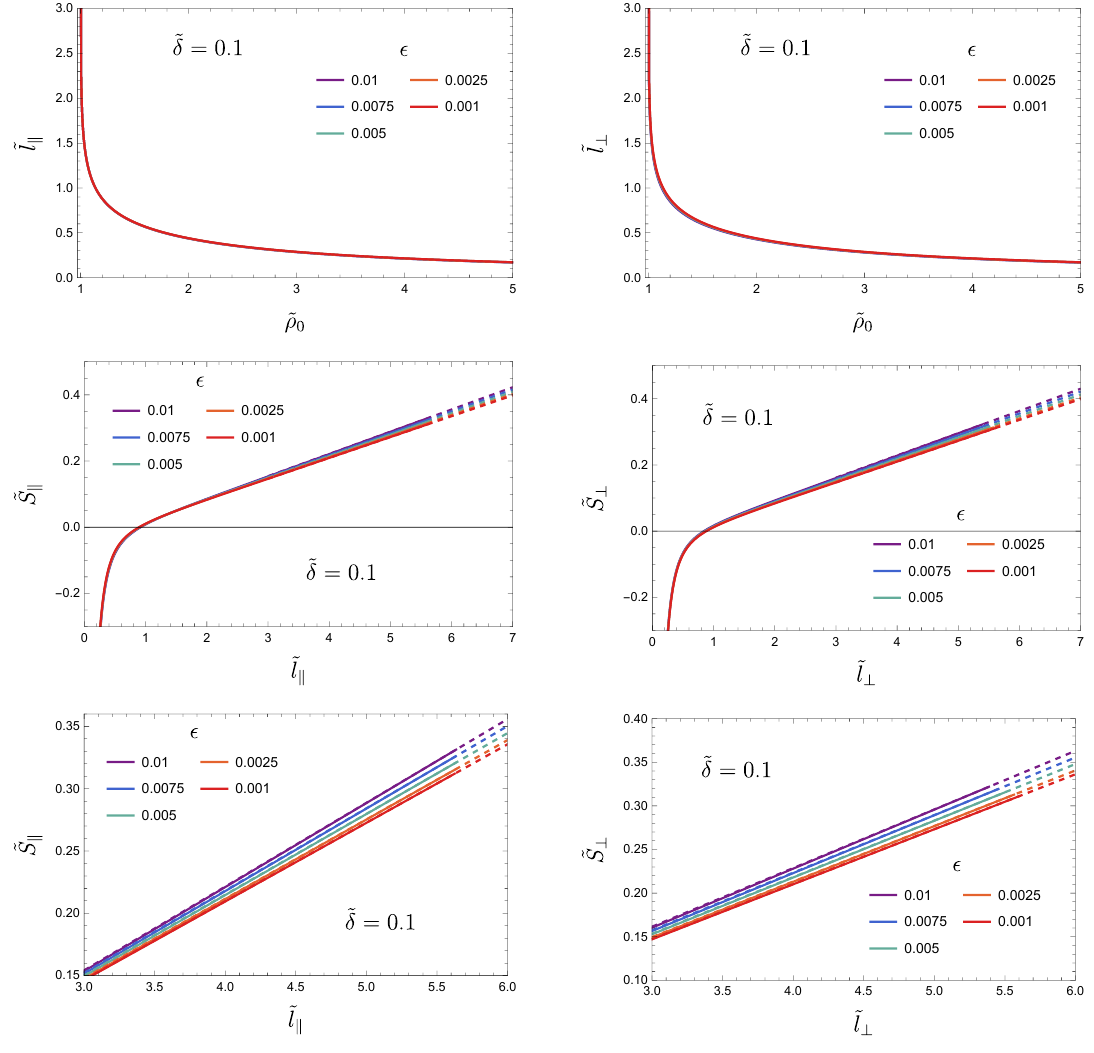
Figure 4 . First row: rescaled parallel (left) and transverse (right) width ˜ l = π T l versus the rescaled turning point ˜ ρ 0 = ρ 0 . Second and third rows: rescaled parallel (left) and transverse (right) ρ h entanglement entropy ˜ S = Vol( M 5 ) S reg versus the rescaled width. The slope of the dashed 8 π 4 L 2 L 3 N 2 c T 2 lines are fixed by the thermal entropy density according to (6.42) and (6.57).